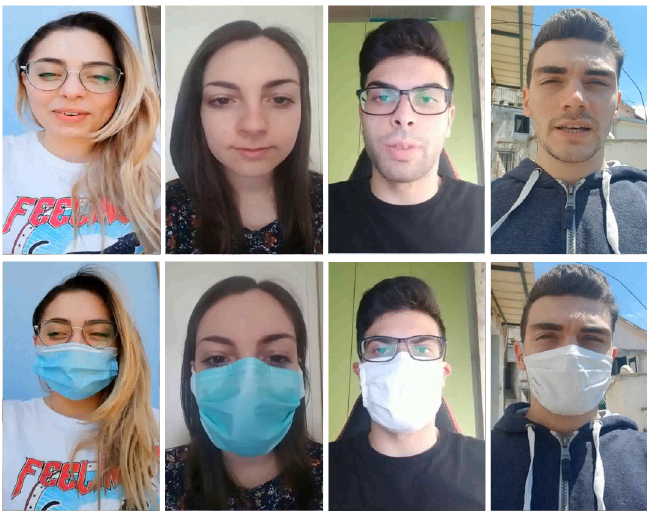
Figure 2. Examples faces with and without masks from the M2FRED